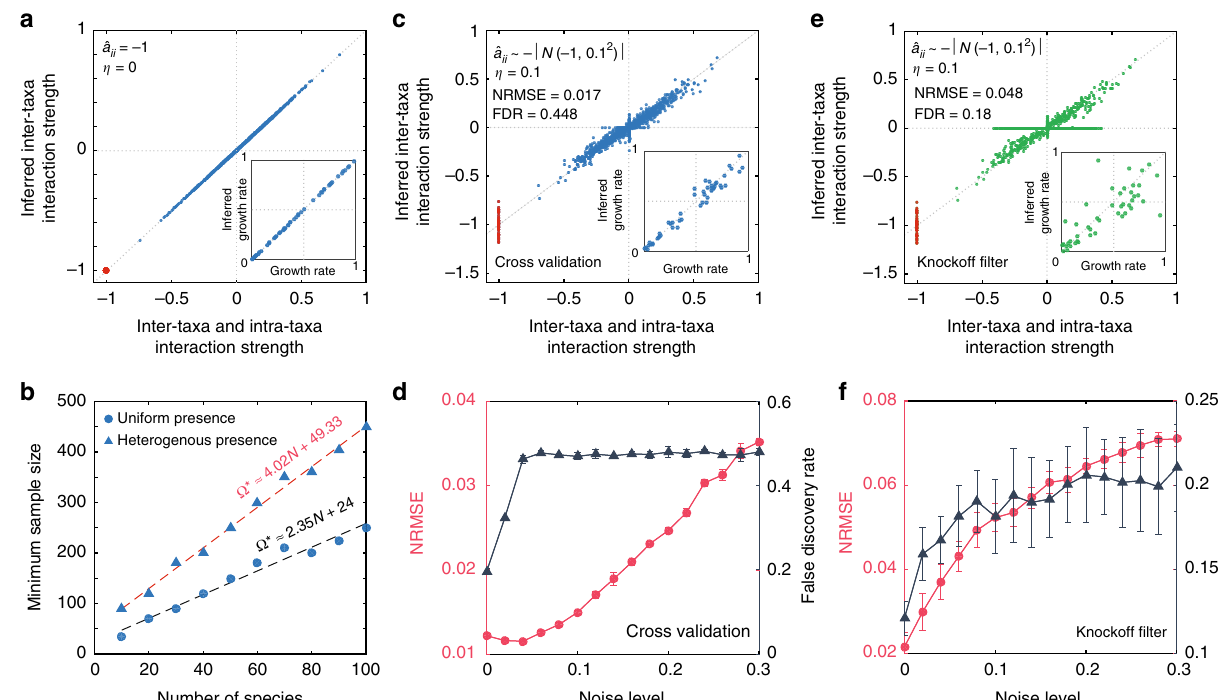
Fig. 4 Validation of our method in inferring interaction strengths using simulated data. Here, we simulate steady-state samples using the GLV model with N taxa and intra-taxa interaction strength a ii ¼ (cid:4) 1 for each taxon. The underlying ecological network is generated from a directed random graph model with connectivity 0.4. The noise is added to steady-state samples as follows: x I i ! x I i þ η u , where the random number u follows a uniform distribution U ½(cid:4) x I i ; x I i (cid:8) , and η is the noise level. a , b Consider the ideal case: (1) noiseless η ¼ 0; and (2) we know exactly a ii ¼ (cid:4) 1. a We can perfectly infer a ij ’ s and r i ’ s. b The minimal sample size Ω (cid:2) required to correctly infer the interaction strengths scales linearly with the system size N . Here we consider two different taxa presence pattern: uniform and heterogenous. c – f In the presence of noise, and during the we just assume that the intra-taxa interaction strengths ^ a ii follows a half-normal distribution. c Using the Lasso regularization induces high false-discovery rate (FDR) ~ 0.448 at η ¼ 0 : 1. d Using classical Lasso with cross validation, both NRMSE and FDR increase with increasing η . e For the same data set used in c , we use the knockoff fi lter to control the FDR below a certain level q ¼ 0 : 2. f With increasing noise level η , FDR can still be successfully controlled below q ¼ 0 : 2 by applying the knockoff fi lter. In sub fi gures a , c – f , we have N ¼ 50. The error bar represents standard deviation for 10 different